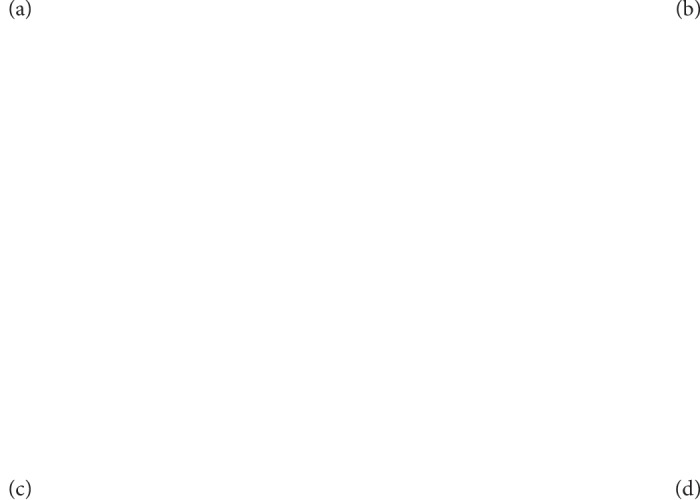
The schematic diagram of the AD rat experimental procedure.